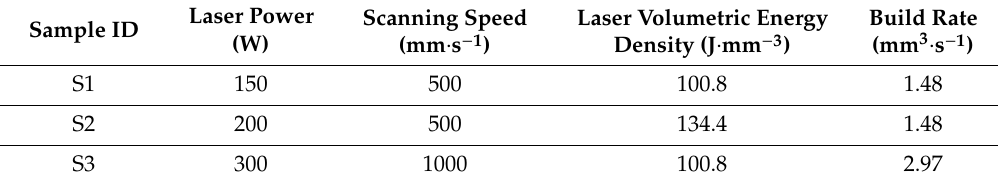
Table 2. Process parameters for samples